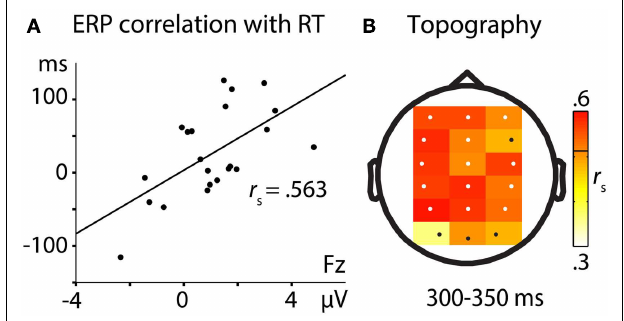
FIGURE 3 | Correlation of ERP differences (think – no-think) with RT differences (no-think – baseline). (A) Correlation at electrode Fz.The positive correlation is indicating more RT memory impairment with more negative no-think ERPs. (B) Topographical distribution of correlation effects at the 18 electrodes selected for statistical analysis. Significant electrodes ( p < 0.05) are depicted in white.The threshold for significant correlation ( r s > 5.121) is depicted as a black line in the color